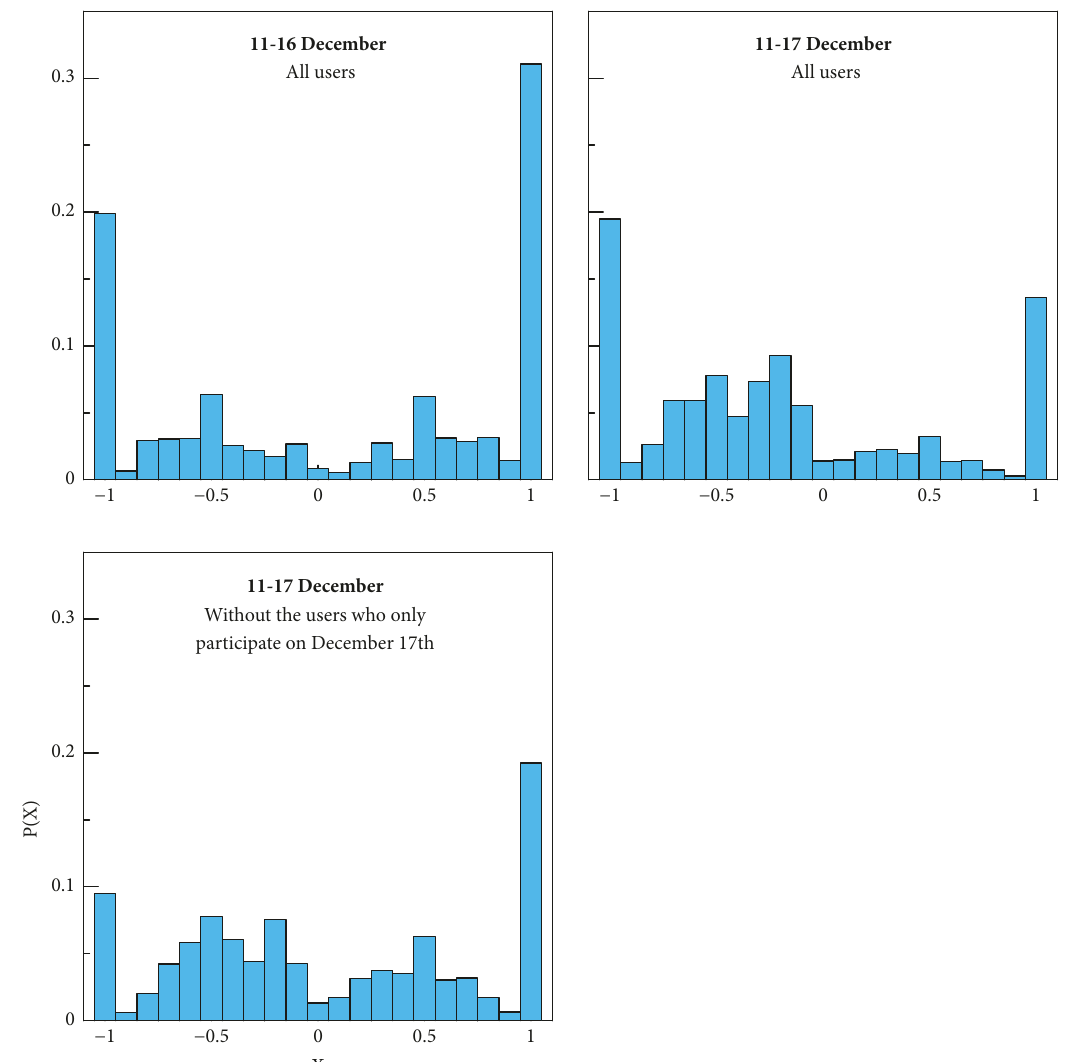
Figure 7: Top panels: opinion distribution estimated from the retweet networks corresponding to the electoral campaign period 11-16 December 2017 (left) and to the electoral campaign period 11-17 December 2017 (right). Bottom panel: opinion distributions from the retweet networks corresponding to the electoral campaign period 11-17 December 2017 eliminating those users who only participate on the voting